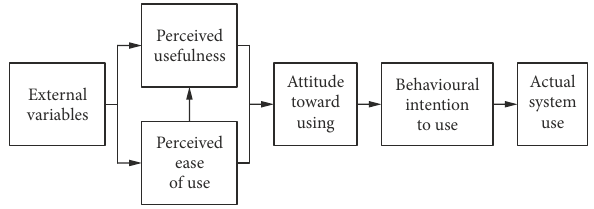
Figure 1. Technology acceptance model (TAM)